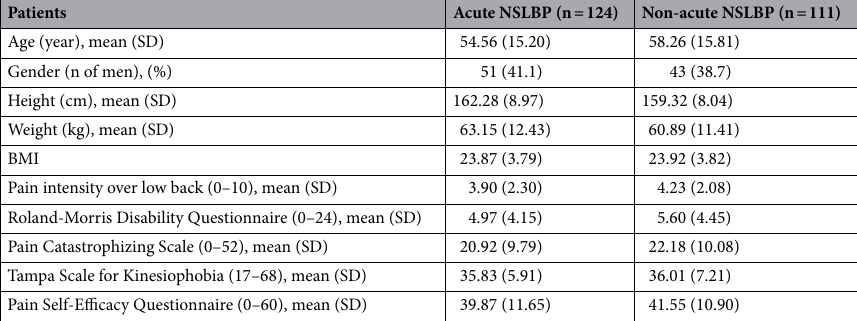
Table 1. Characteristics of the participants.